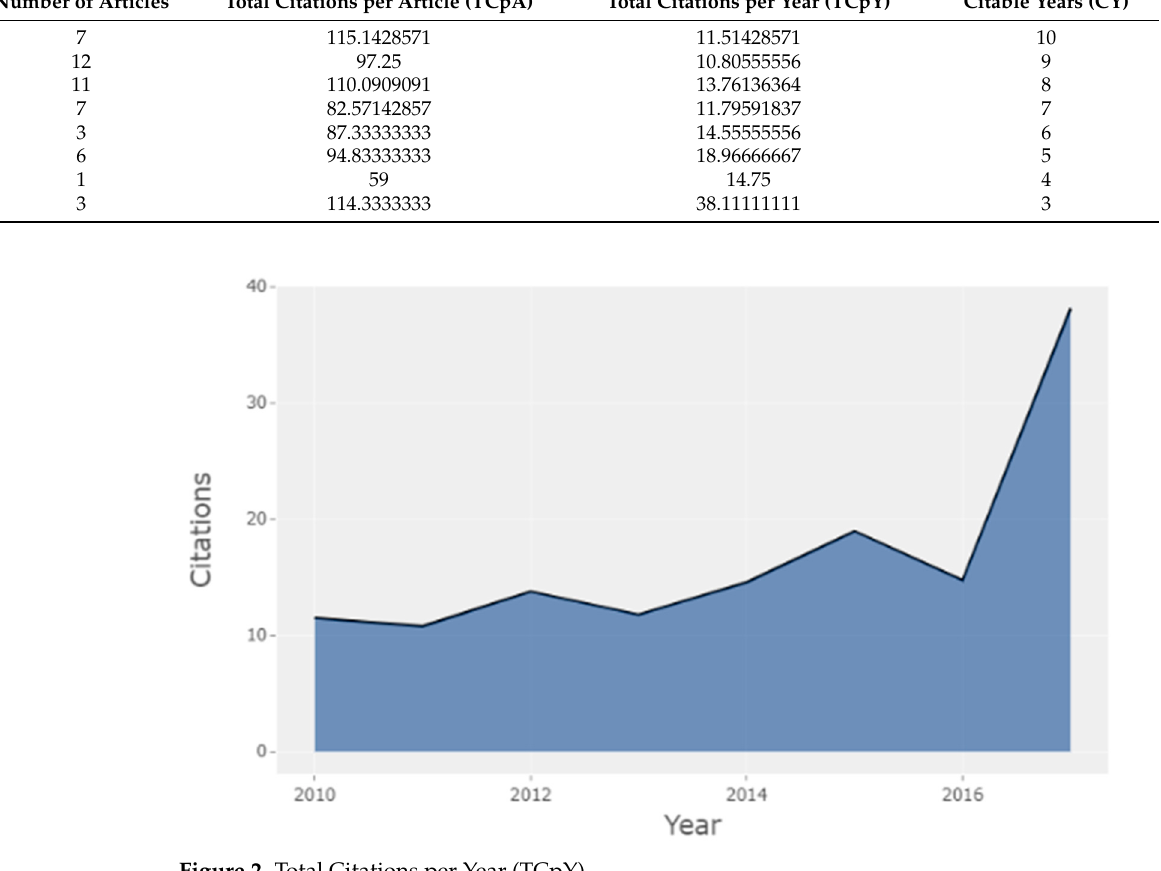
Figure 2. Total Citations per Year